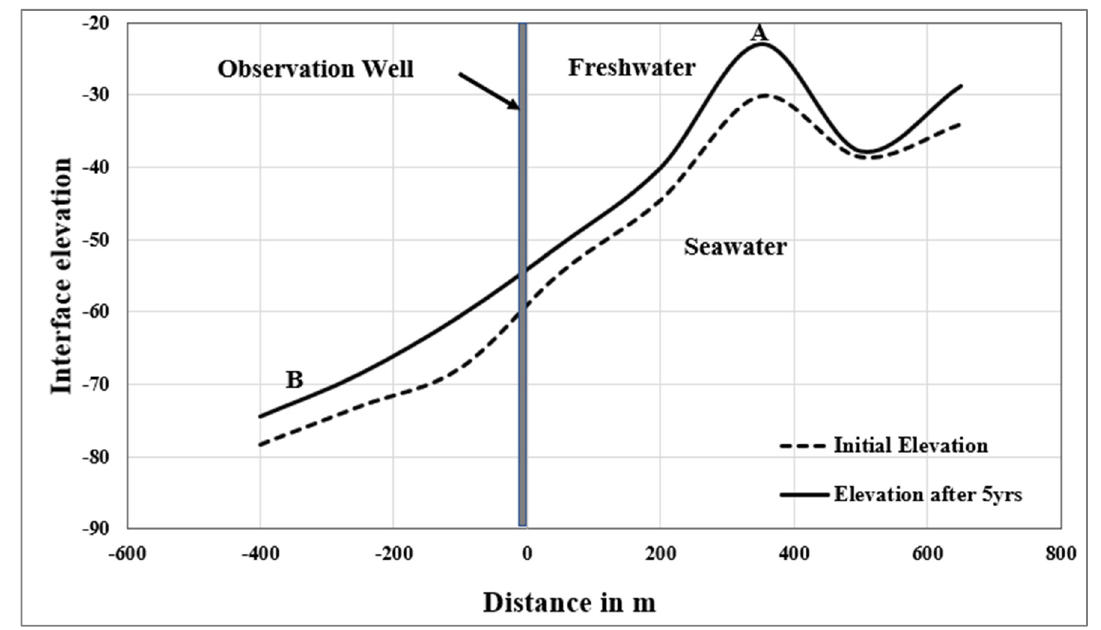
Figure 6. Fresh groundwater-saltwater transition zone elevation variation in function of groundwater level and sea level fluctuation.